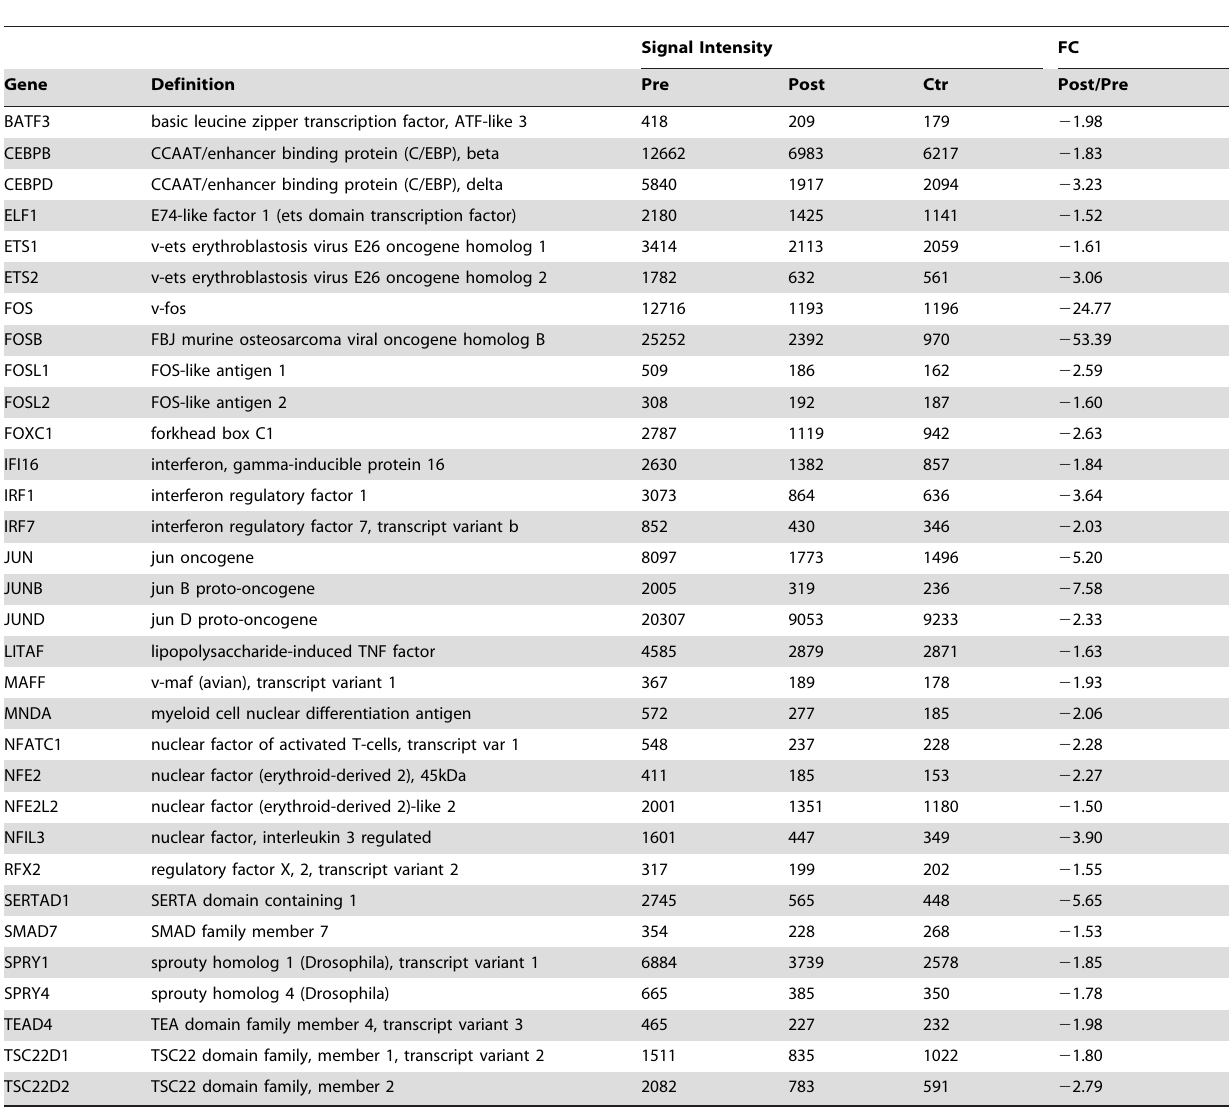
Table 2. Down-regulated genes in adipose tissue after profound fat loss (PANTHER category Other transcription factor, q- value= 0).